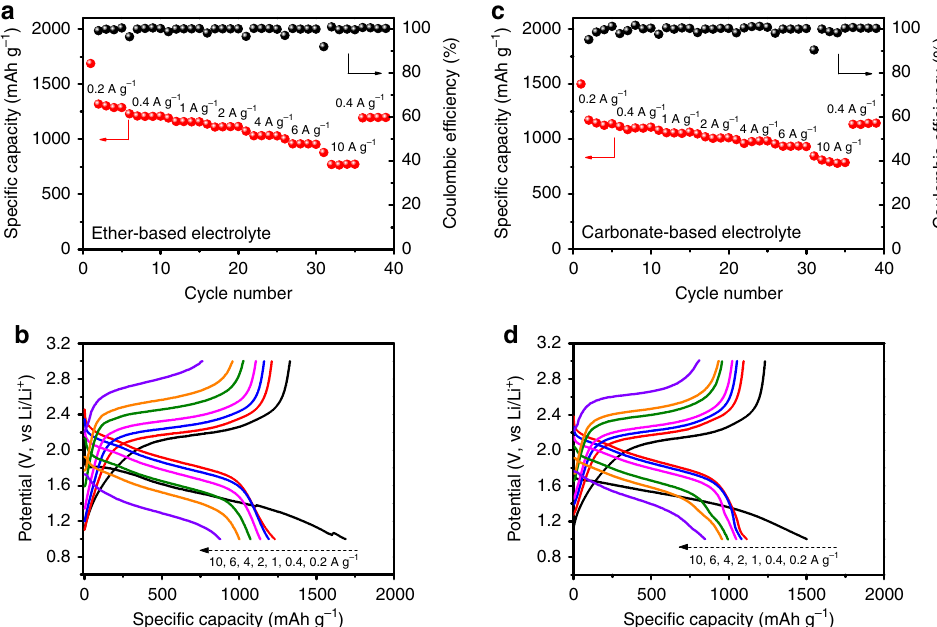
Fig. 3 Electrochemical performance of the lithium – sulfur batteries. a Rate performance of the Se 0.06 SPAN measured at various current densities in ether- based electrolyte. The current densities are same for both charge and discharge in each cycle. b The corresponding electrochemical discharge and charge pro fi les of Se 0.06 SPAN at various cycles. c Rate performance of the Se 0.06 SPAN measured at various current densities in carbonate-based electrolyte. d The corresponding electrochemical discharge and charge pro fi les of Se 0.06 SPAN at various